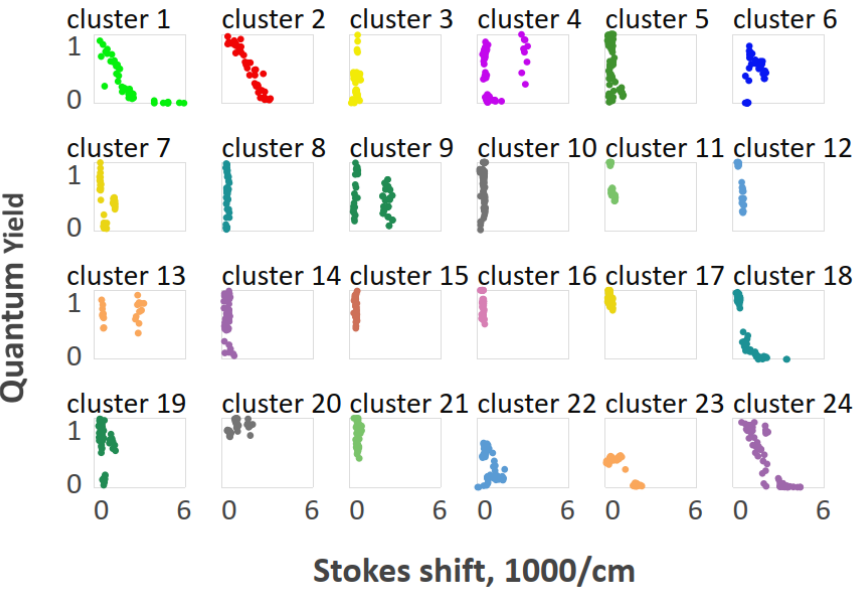
Figure 10. Quantum yield versus Stokes shift diagram in terms of 1000/cm for a 24-cluster dataset of 115 BODIPYs, in decreased order, of parameter A.